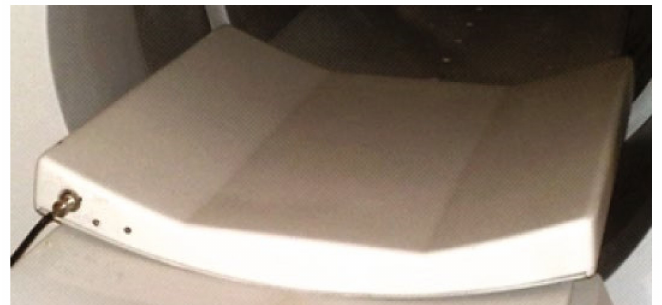
Figure 2. Sodium Whole Body coil. Reprinted by permission from Anisimov et al., App Magn Reson 2019